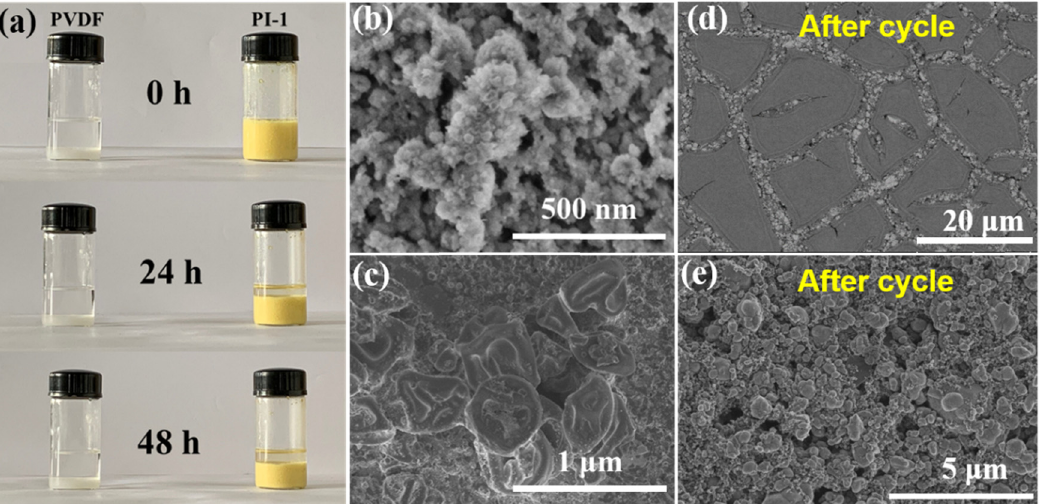
Figure 5: ( a ) Digital photographs of PVDF and PI powders after immersing in the electrolyte for di ff erent times; SEM images of ( b ) PVDF and ( c ) PI powders after immersing in electrolyte for 48 h; SEM images of ( d ) LFP – PVDF and ( e ) LFP – PI electrode fi lms after cycling